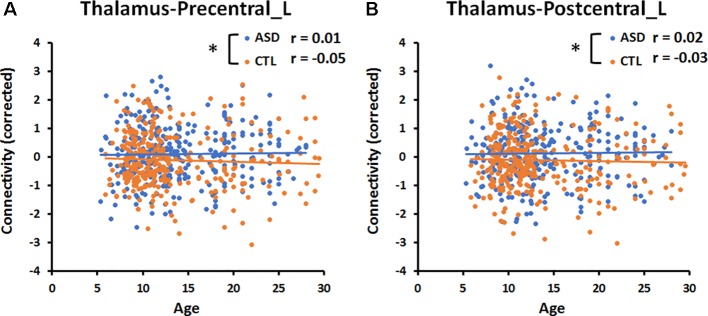
Significant age-by-group interaction effect on thalamocortical connectivities. (A) The correlation between age and connectivity in the thalamus-precentral gyrus of the left hemisphere was weakly negative (r = −0.05) in the CTL group, but near zero (r = 0.01) in the ASD group. (B) The correlation between age and thalamus-postcentral gyrus of the left hemisphere was weakly negative (r = −0.03) in the CTL group, but weakly positive (r = 0.02) in the ASD group. An asterisk indicates a significant age-by-group interaction effect (p < 0.05, uncorrected). Blue and orange lines indicate the regression lines of ASD and CTL, respectively.